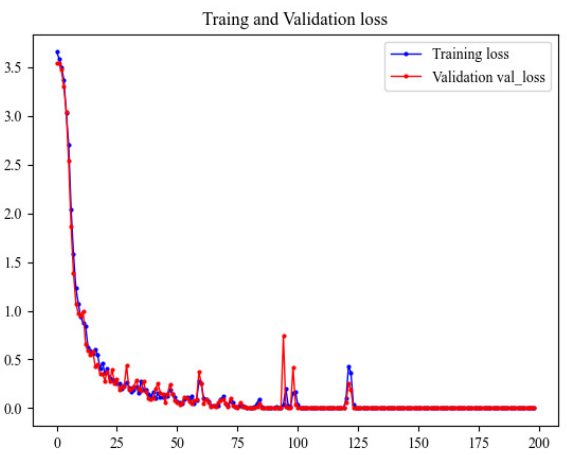
Figure 13. Training loss in the process of associated fault diagnosis.